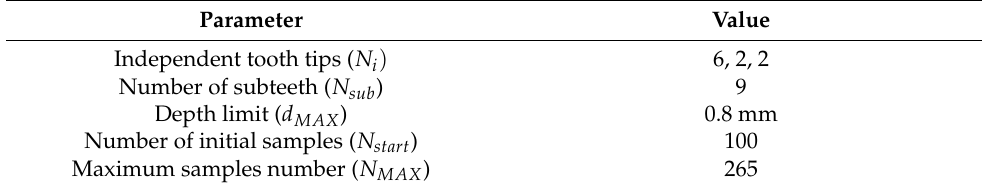
Table 3. Actual values of the main design parameters.